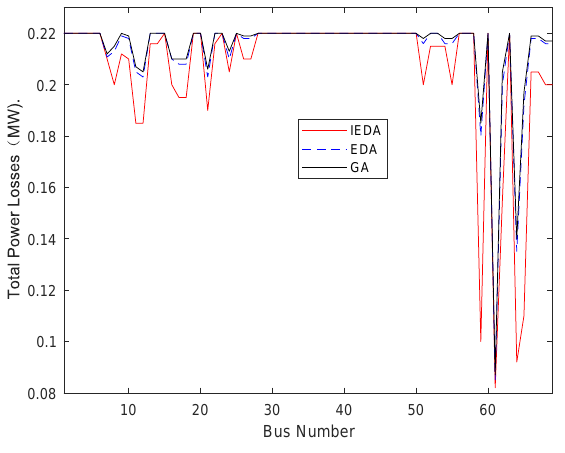
Figure 13. Voltage distribution of the 69 bus radial distribution system.